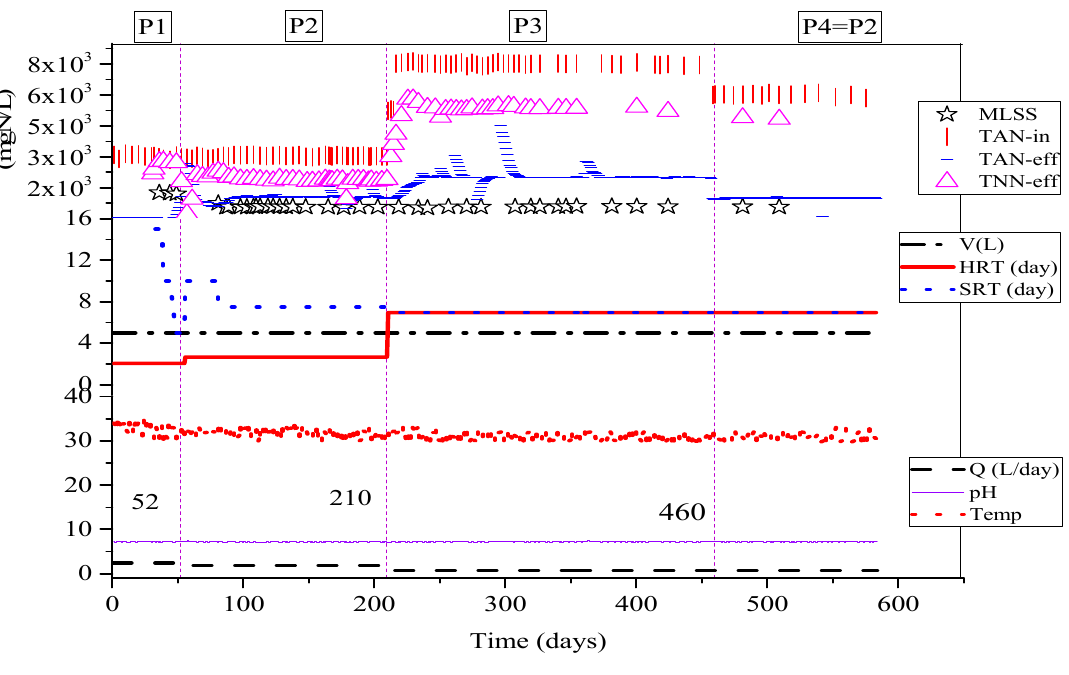
Figure 2. Daily performance of CSTR (B) from phase 1 to phase 4.